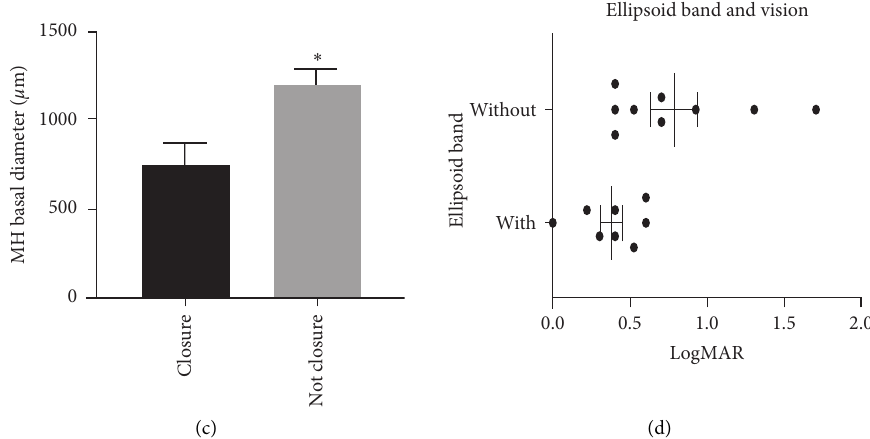
Figure 2: (a) Patients’ mean ages for both groups. The mean age was 12.0 ± 1.63 years in the spontaneous closure group and 27.0 ± 12.7 years in the vitrectomy group ( p � 0.009). (b) In the spontaneous closure group, the basal diameter was 418.0 ± 283.6 μ m, whereas the diameter was 943.0 ± 444.2 μ m in the vitrectomy group ( p � 0.02). (c) The preoperative basal diameter was 754.8 ± 475.4 μ m in the eyes with successful macular hole closure and 1204.5 ± 132.2 μ m in the eyes without macular hole closure ( p � 0.02). (d) The relationship between ellipsoidal band and postoperative BCVA. The eight cases with ellipsoid band integrity demonstrated better average BCVA than those without ellipsoid band integrity ( p � 0.03).